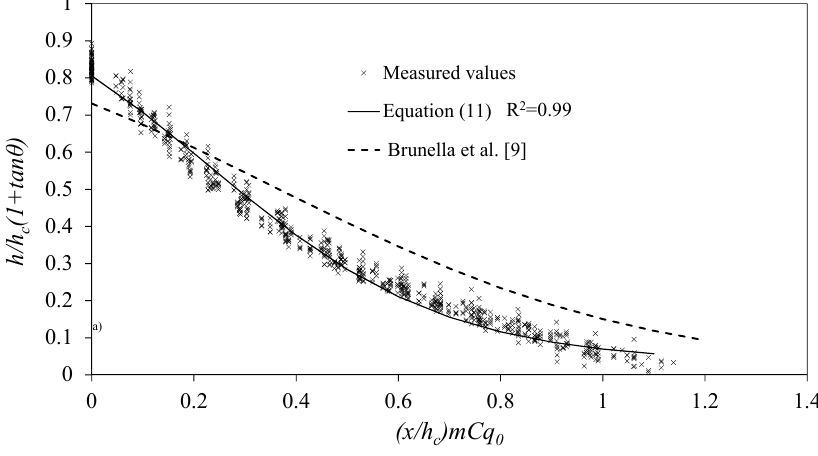
Figure 7. Flow profile measured values and adjustment proposed in Equation (11).